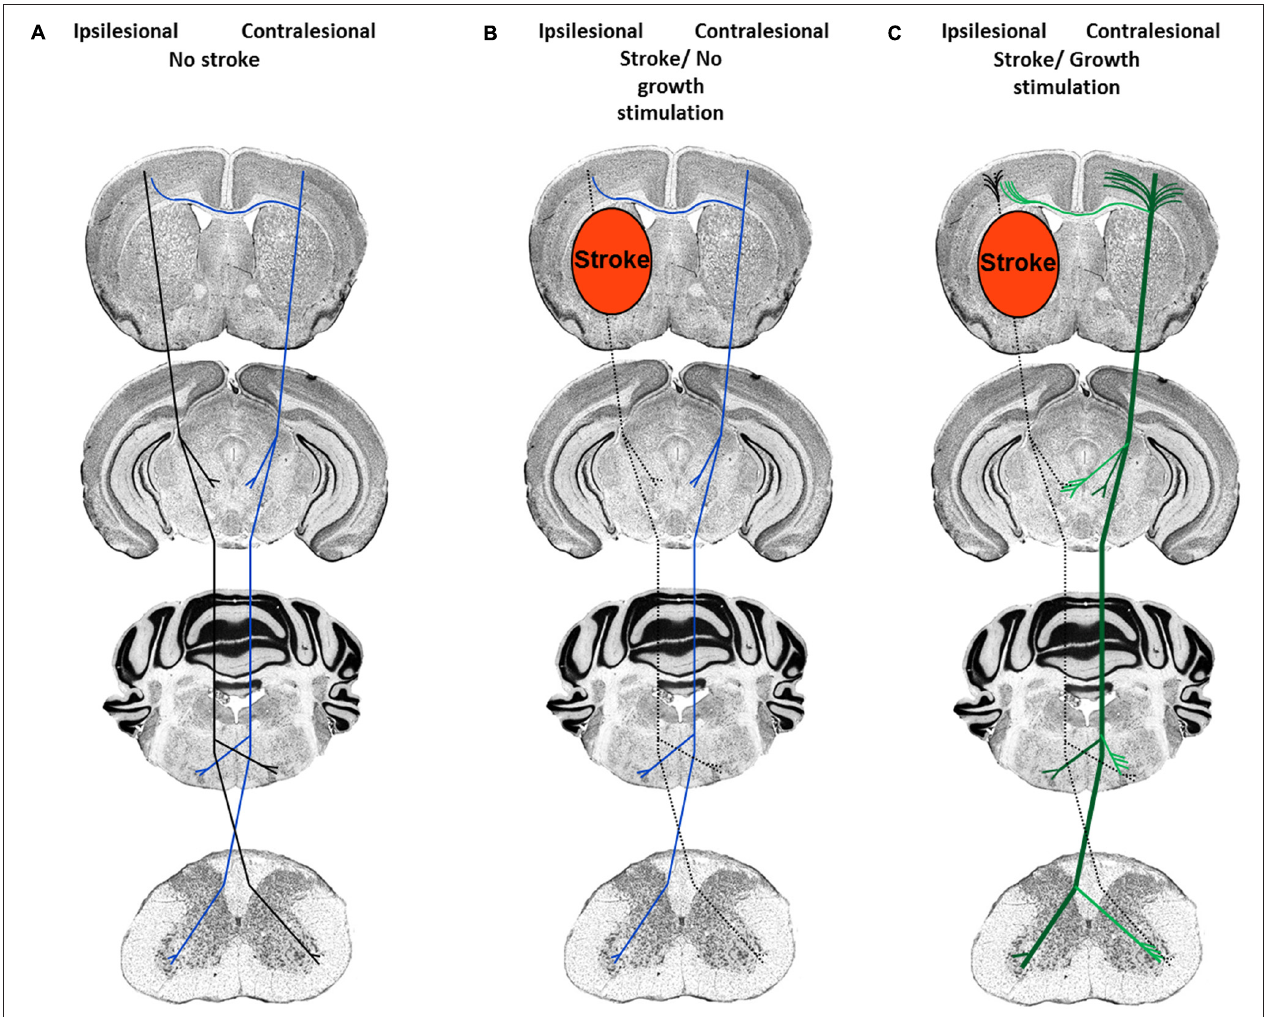
FIGURE 1 | Neuronal plasticity features of cortical neurons in response to stroke and neuronal growth stimulation. (A) Organization of the corticospinal tract previous to the stroke. Ipsilesional fibers are depicted in black and contralesional fibers in blue. (B) After ischemic stroke induced by middle cerebral artery occlusion, pyramidal tract axons in the ipsilesional hemisphere degenerate (dashed lines), whereas contralesional pyramidal tract axons and dendrites exhibit scarce sprouting. (C) After growth stimulation, short-distance cortical dendrites exhibit abundant sprouting both ipsilateral (black) and contralateral (green) to the stroke, whereas long-distance axon collaterals grow out across the midline (exemplified here at the level of the red and facial nuclei and spinal chord) in direction to denervated target neurons. Post-stroke, the augmentation of contralesional axon collateral sprouting is accompanied by the improvement of motor and coordination